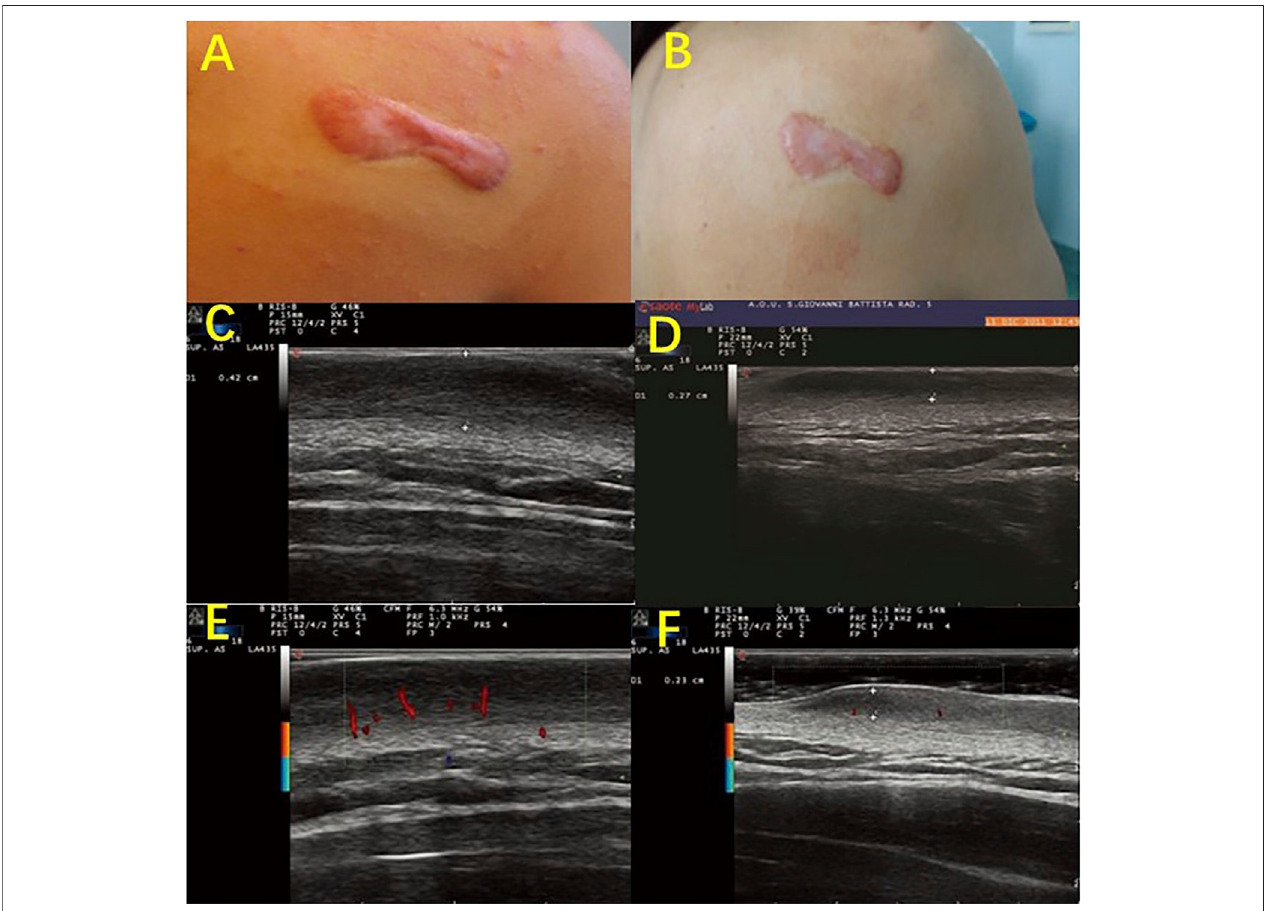
FIGURE 3 | Color-Doppler ultrasonography evaluates the characteristic vasculature of scars. Photography of a scapular keloid before treatment (A) and after 1 month of treatment with a Pico device (B) . B-mode Ultrasound images of the keloid before treatment (C) , after 1 month of treatment (D) , and after 2 months of treatment with a Pico device (F) , show that the keloid thickness was reduced from 0.42 to 0.27 cm and then to 0.23 cm. Color-Doppler ultrasound images showed palisade vessels in the keloid before treatment € , and palisade vessels disappeared after 2 months of treatment with a Pico device (F) .